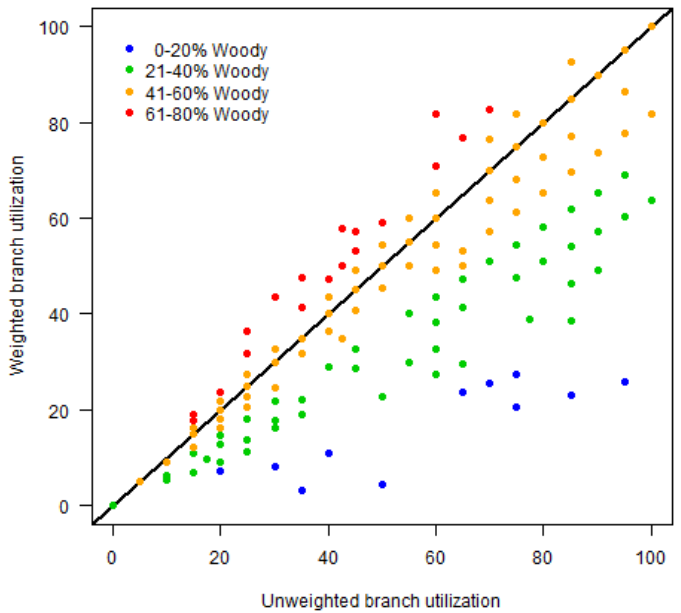
Figure 5. Relationship between unweighted and weighted measures of elephant utilization along the Chobe riverfront, Botswana. The 1:1 line is indicated in black for comparison. The weighted utilization measure penalizes the values of plots with few trees (blue and green), shifting them below the 1:1 line, and emphasizes those with higher woody cover (red), shifting them above the line. See text for